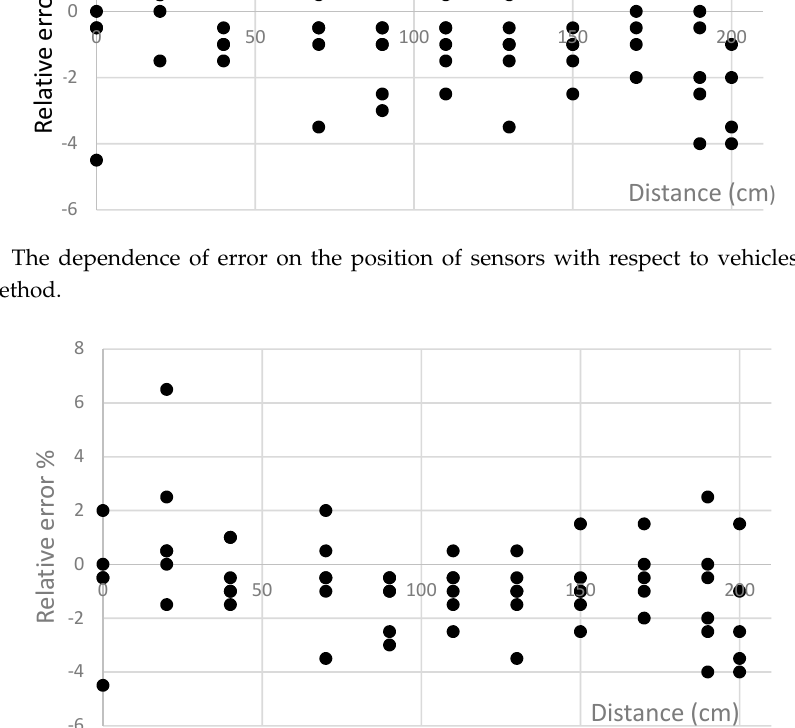
Figure 9. The dependence of error on the position of sensors with respect to vehicles using the tenth method.